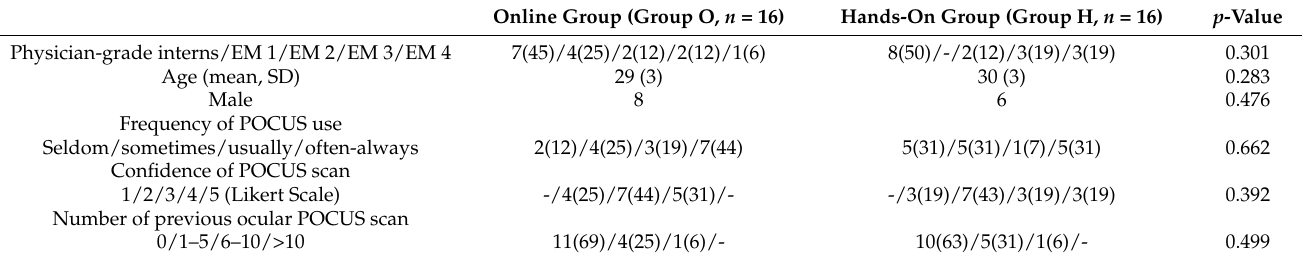
Table 1. Baseline characteristics of study participants. Online Group (Group O, n =